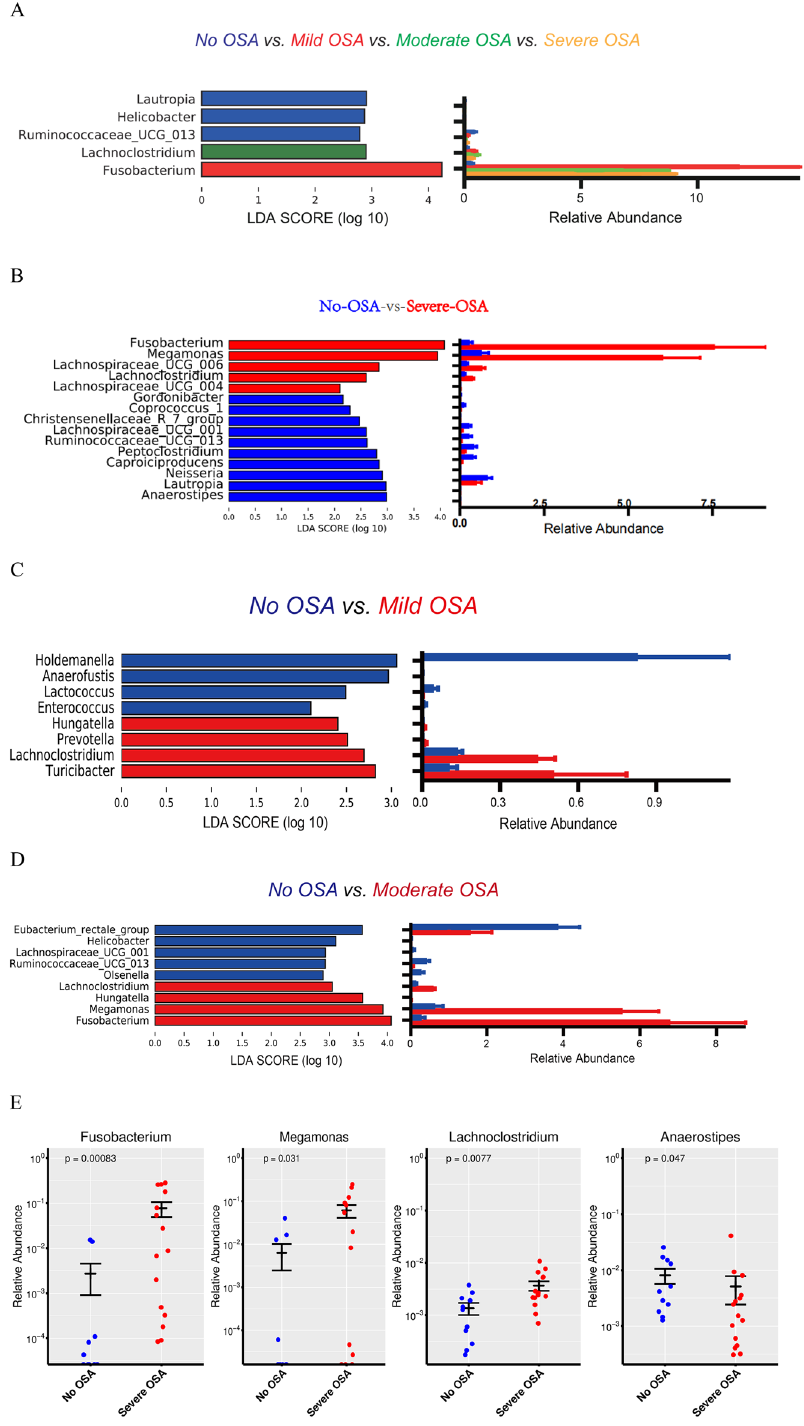
Figure 4. Taxa differences in different severity OSA. LEfSe identifies microbiota differences in ( A ) Different severity groups of OSA versus no OSA (Kruskal–Wallis), ( B ) severe OSA versus no OSA (Wilcox). ( C ) Mild OSA versus no OSA(Wilcox). ( D ) moderate OSA versus no OSA (Wilcox). ( E ) Scatter plot of the bacteria at the genus level with relative abundance greater than 0.5% in all samples in severe OSA participants